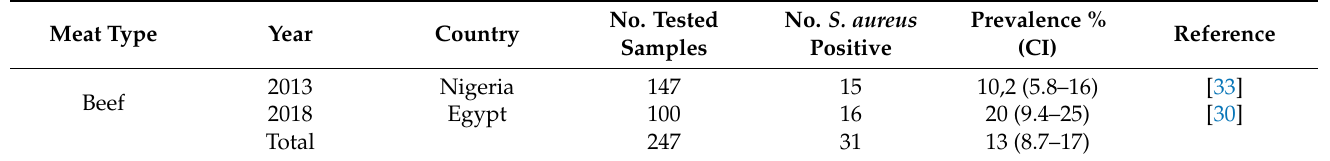
Table 3. Prevalence of S. aureus in raw processed meat.